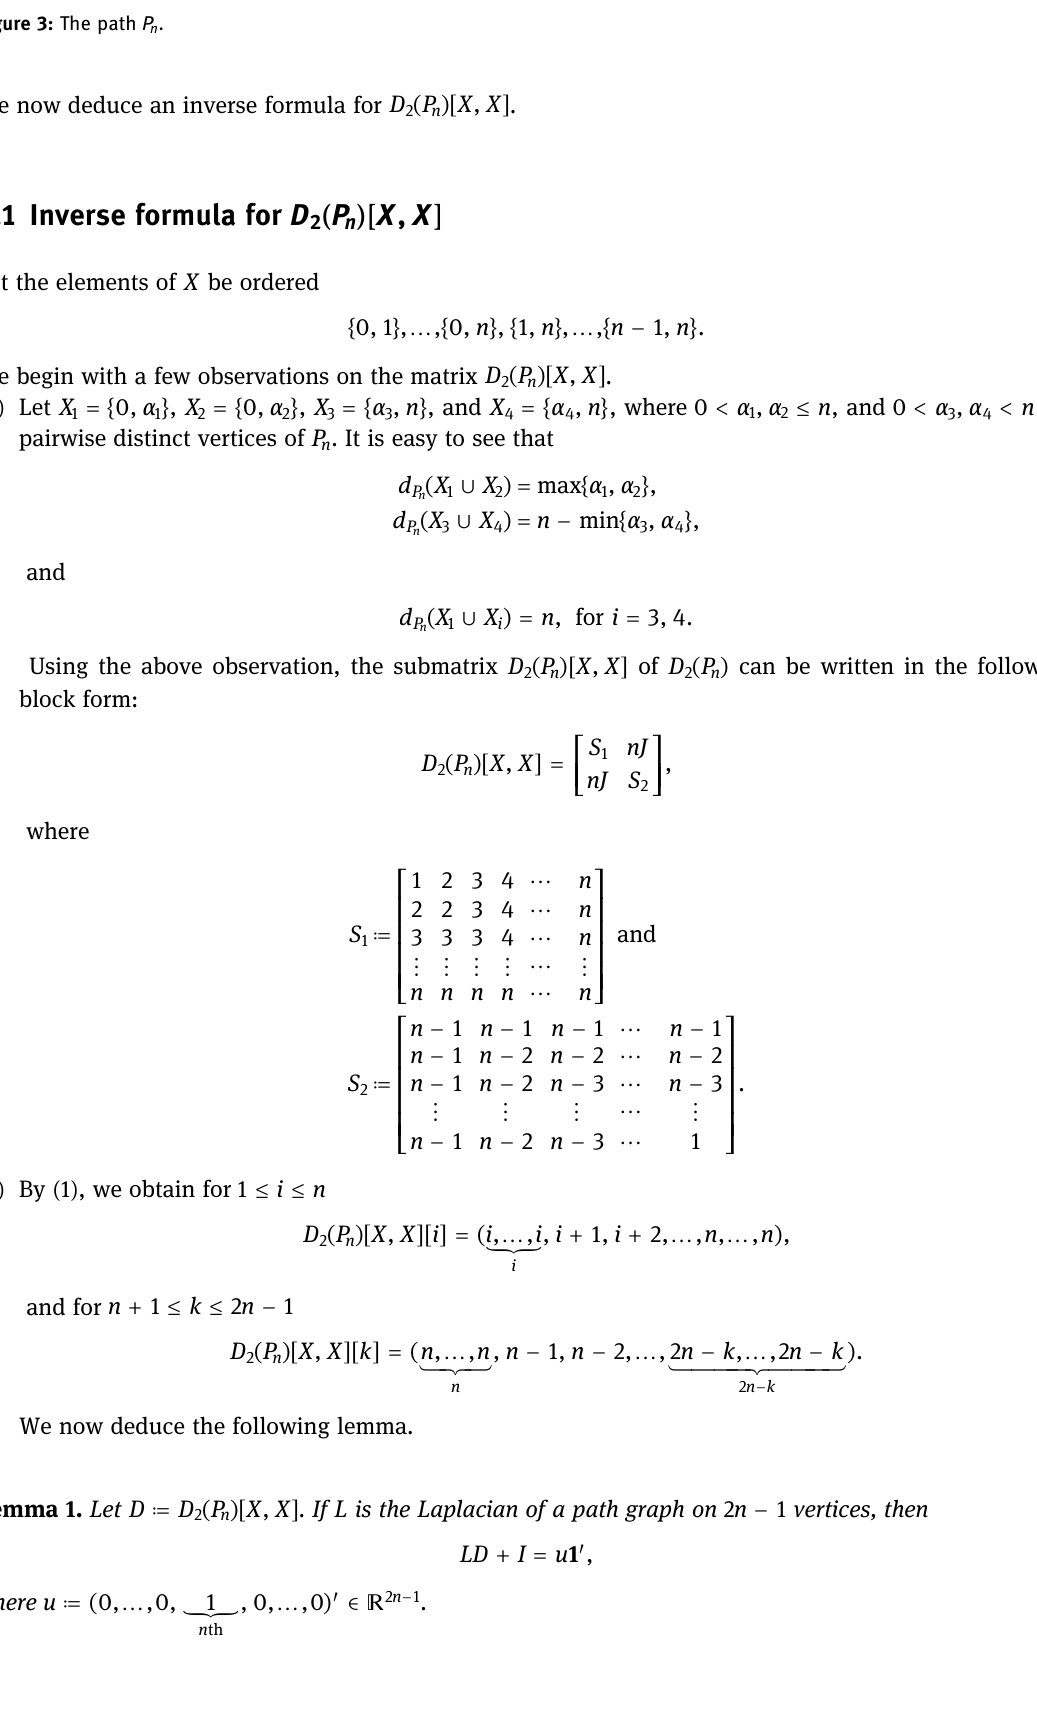
Figure 3: The path P n